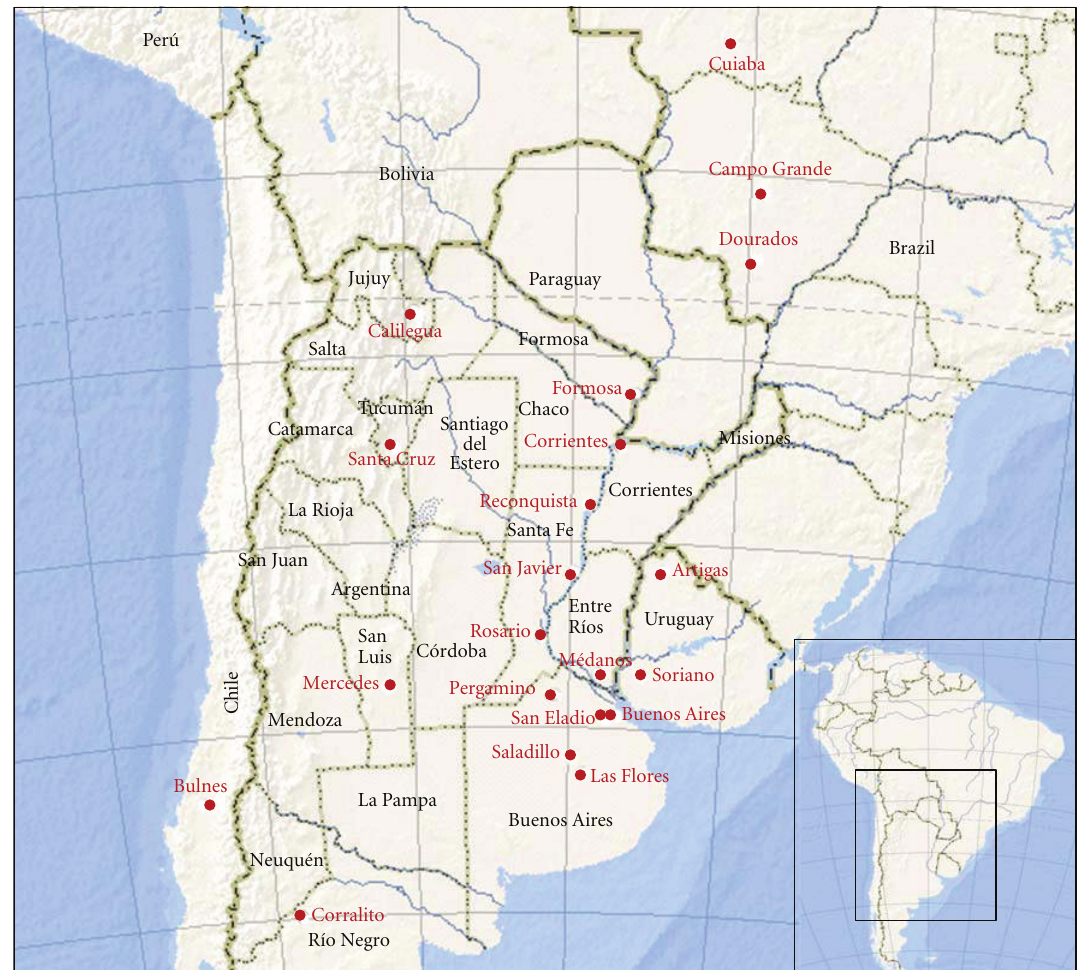
Figure 1: Red dots showing localities in Argentina, Brazil, Uruguay, and Chile mentioned in the paper